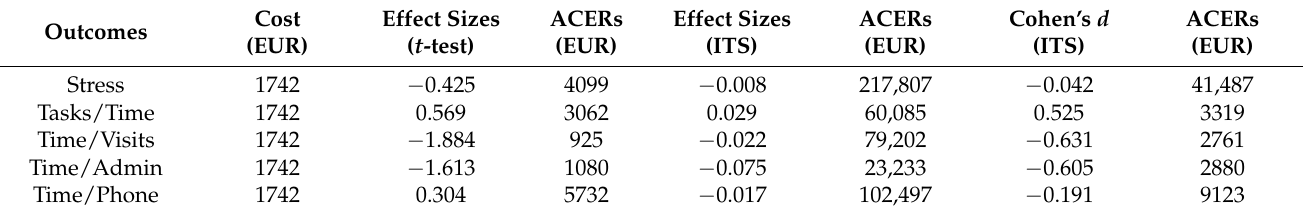
Table 6. Average cost-effectiveness ratio for each outcome